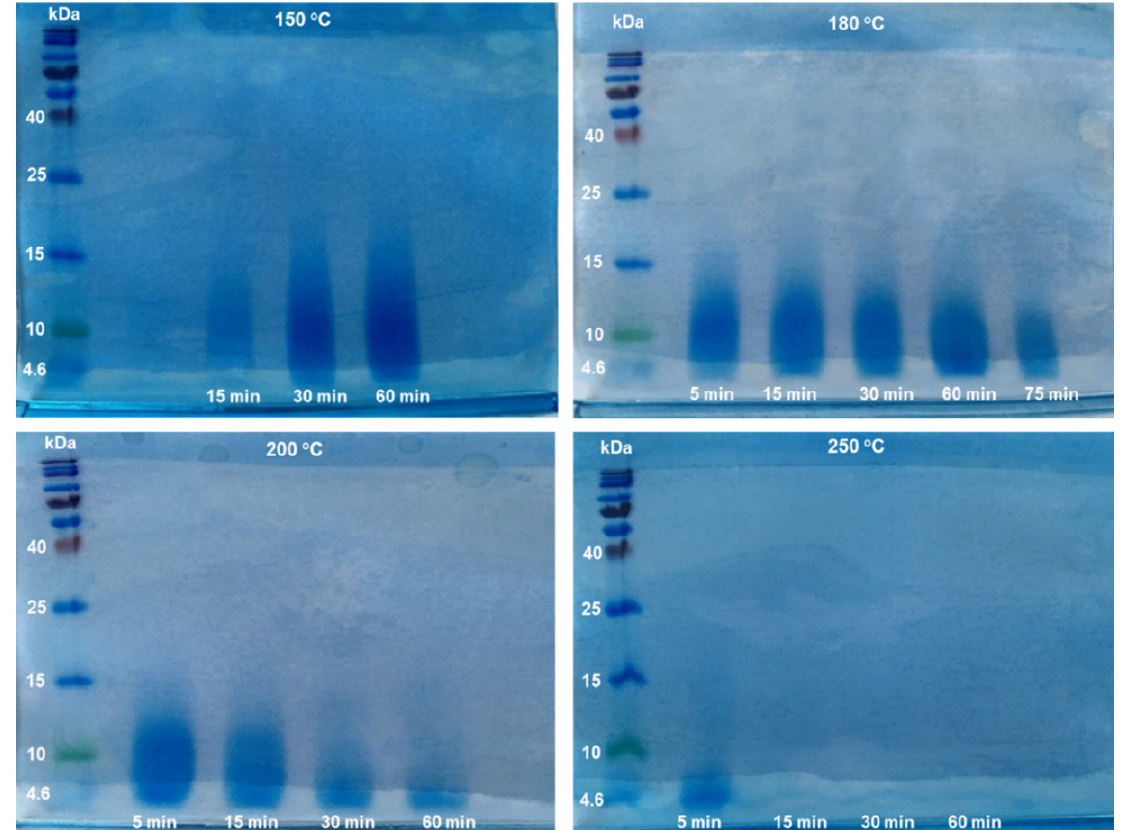
Figure 6. SDS-PAGE electrophoresis gels of isolated